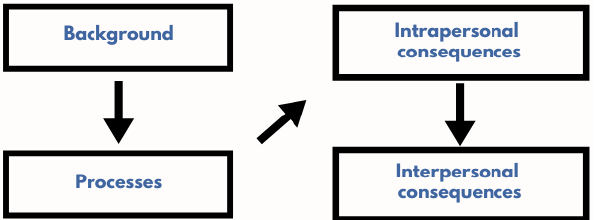
Figure 3. Formalization of the IRI conceptual model [elaborated by